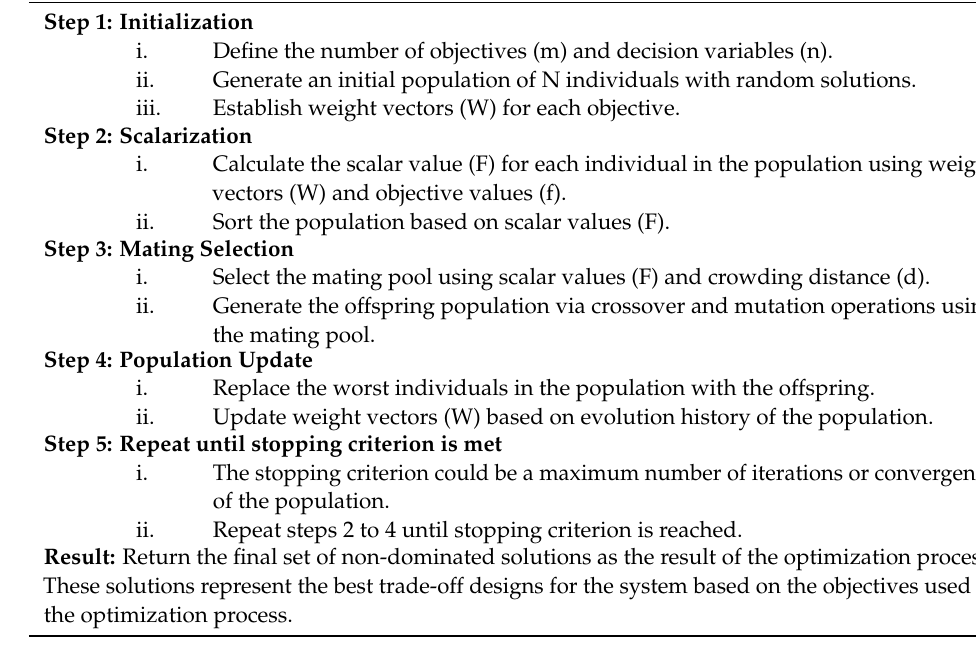
Algorithm 4: Multi-Objective Evolutionary Algorithm based on Decomposition